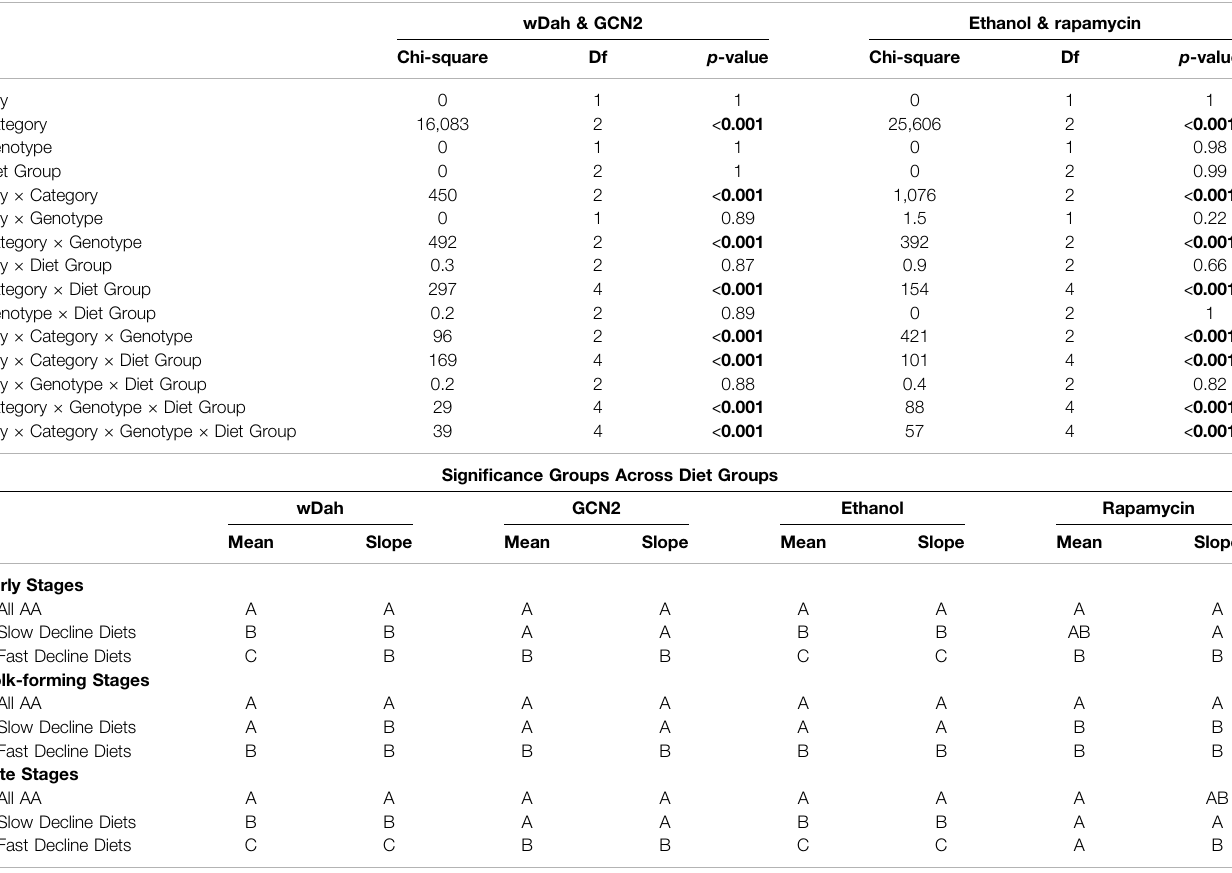
TABLE 5 | Manipulating both diet and either GCN2 or Target of Rapamycin signalling alters the percentage of egg chambers in each category over time. Categories include early stages (egg chamber stage 1 – 7), yolk-forming stages (stages 8 – 11), and late stages (12 –